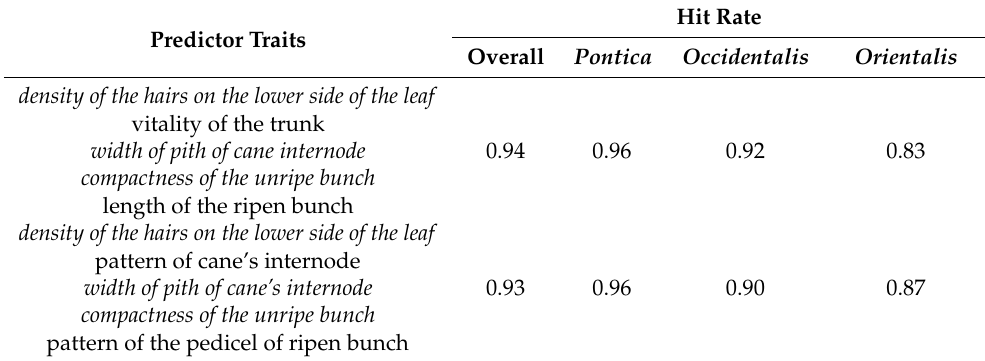
Table 2. The rate of correct classifications in the test set (overall hit rate) and the subtests pontica, occidentalis, and orientalis resulted in using five predictors with the random forest method. The best three-predictor-combination set is in